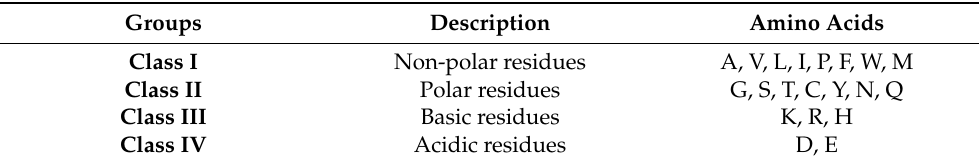
Table 3. Classification of 20 amino